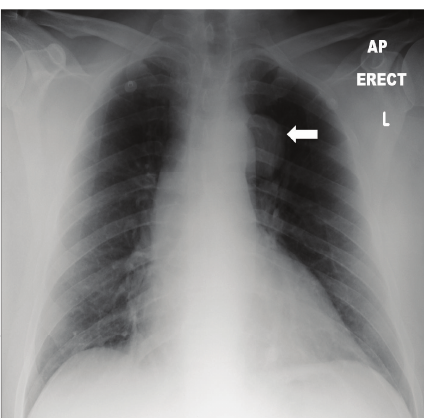
Figure 1: Chest radiograph in a 50-year-old male patient with Castleman disease. A soft tissue pleural-based mass is seen superior to the left hilum (arrow).